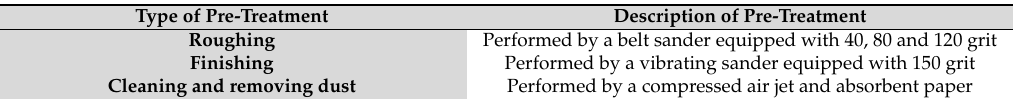
Table 3. Description of surface pre-treatment. Type of